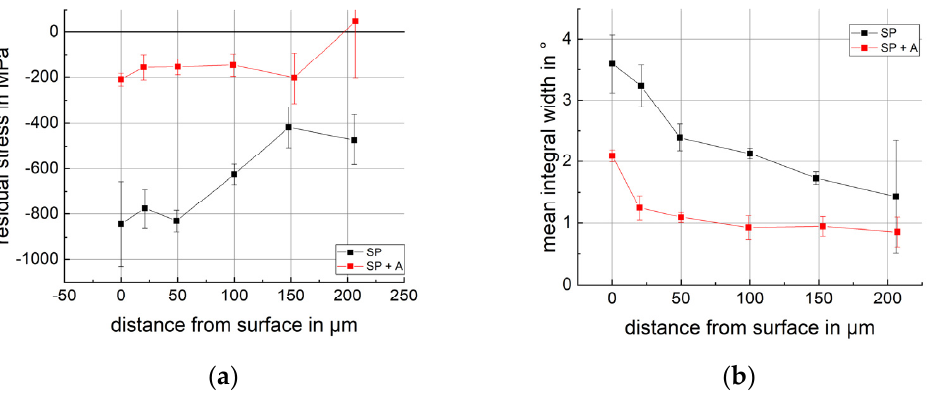
Figure 4. Result of X-ray stress analysis: ( a ) Residual stress depth distributions for the SP and the SP+A samples and ( b ) the corresponding depth distributions of the mean integral widths of the diffraction lines.